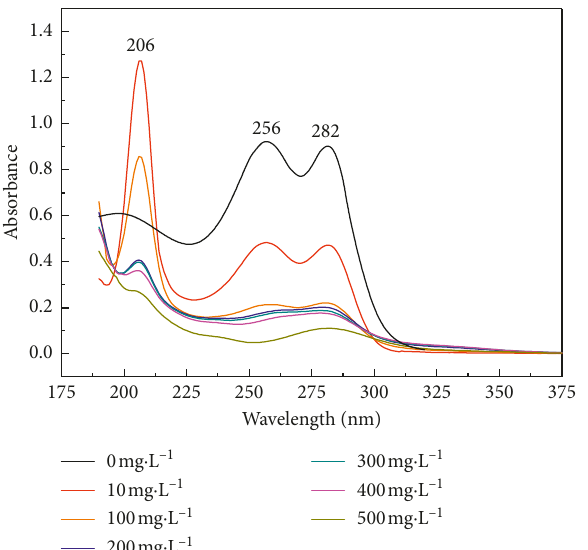
Figure 10: Influence of the dosage of sodium hypochlorite on the UV absorption spectrum of reaction